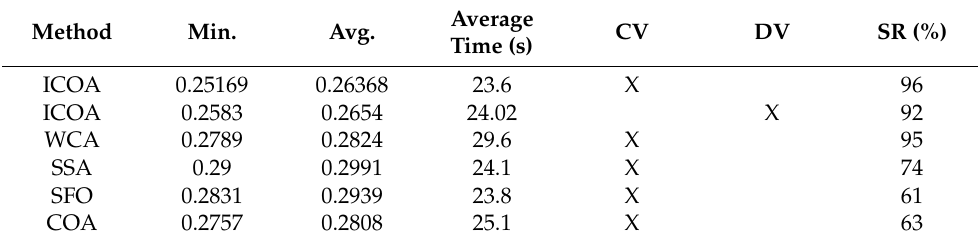
Table 10. Result comparison of L index for the IEEE 57-bus system.